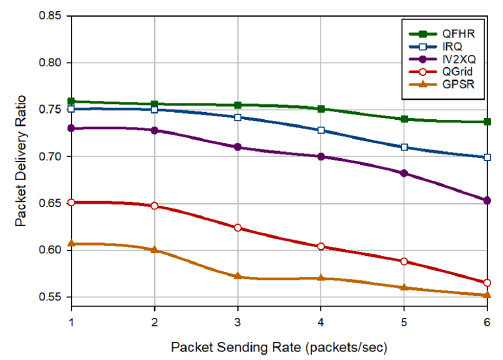
Figure 10. PDR in different approaches based on PSR.